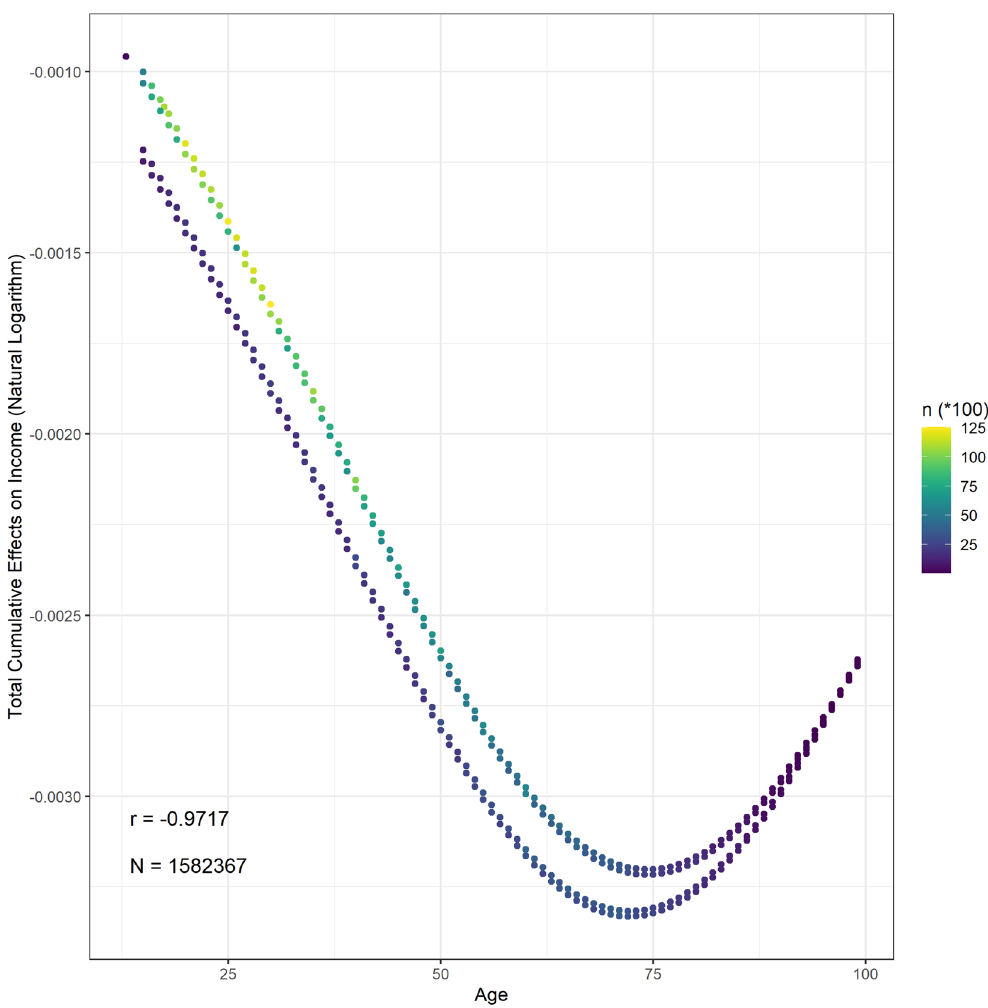
Figure 4. The distribution between the total cumulative effects of age on